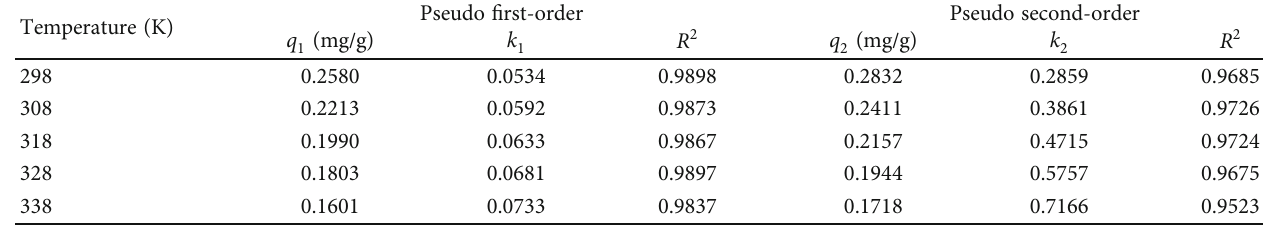
Table 5: The fi tting kinetic parameters for PFO and PSO.